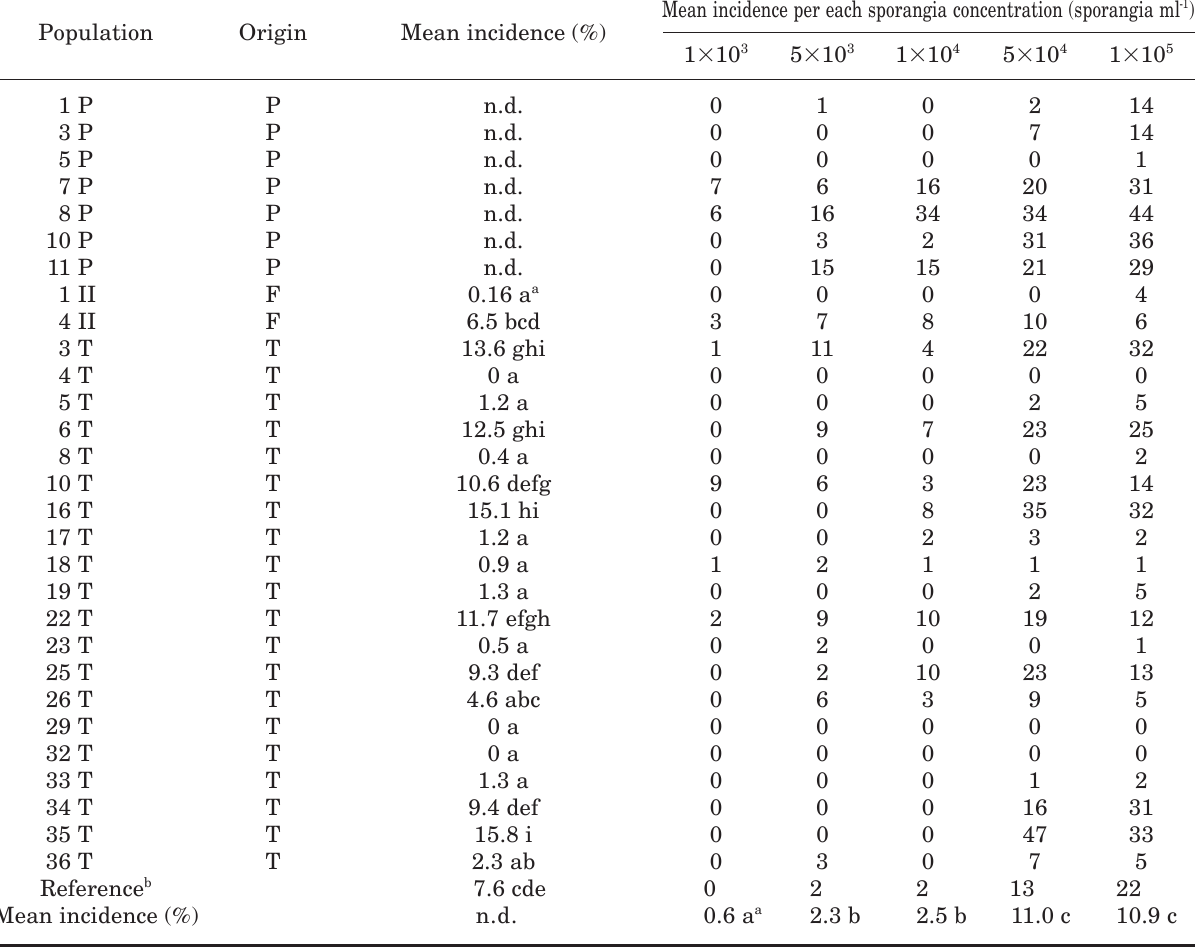
Table 5. Leaf disc test. Mean incidence of P. viticola as percent leaf area showing downy mildew infection 12 days after inoculation with populations of P. viticola from vineyards located in Piedmont (P) in 2002, Friuli Venezia Giulia (F) in 2002 and Trentino (T) in